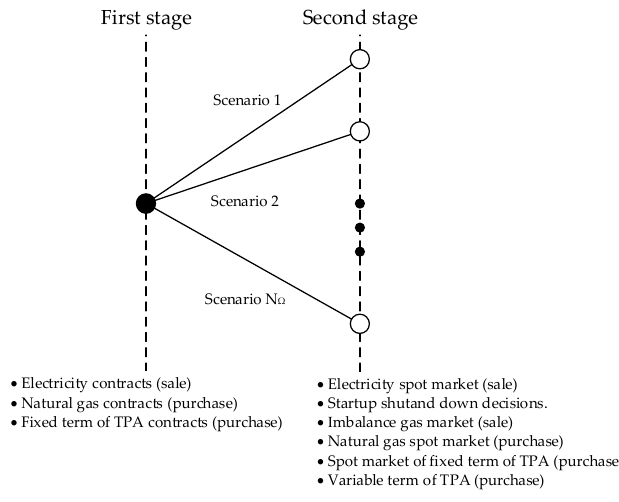
Figure 3. Decision ‐ making framework. Figure 3. Decision-making